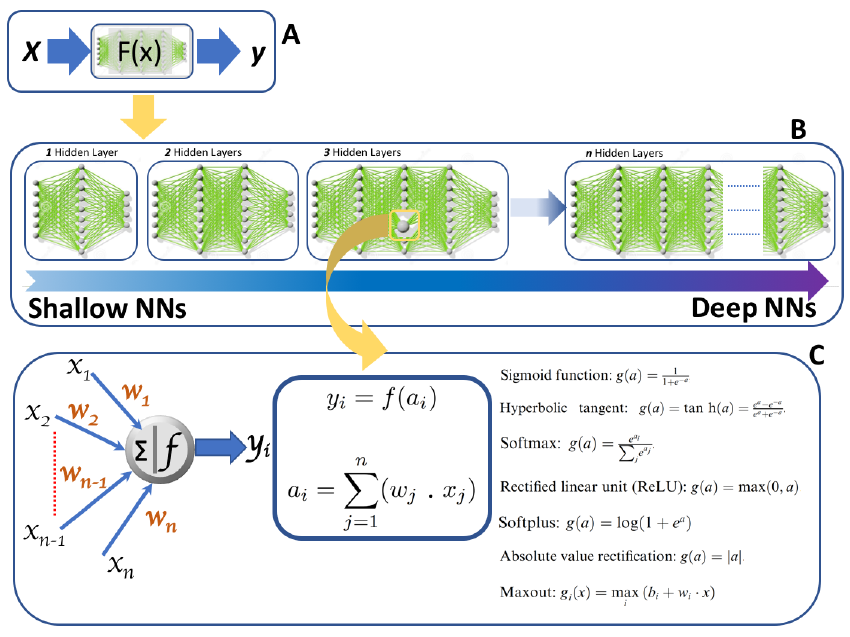
Figure 4. Artificial neural